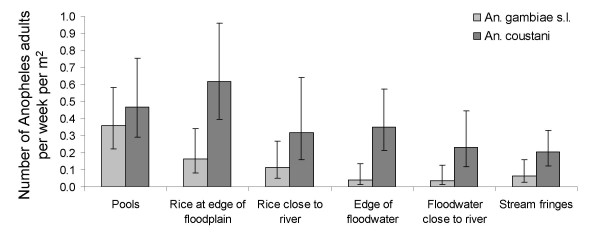
Average adult anopheline densities per week and m2 in different habitat types during the rainy season 2005. Error bars show 95% confidence intervals.